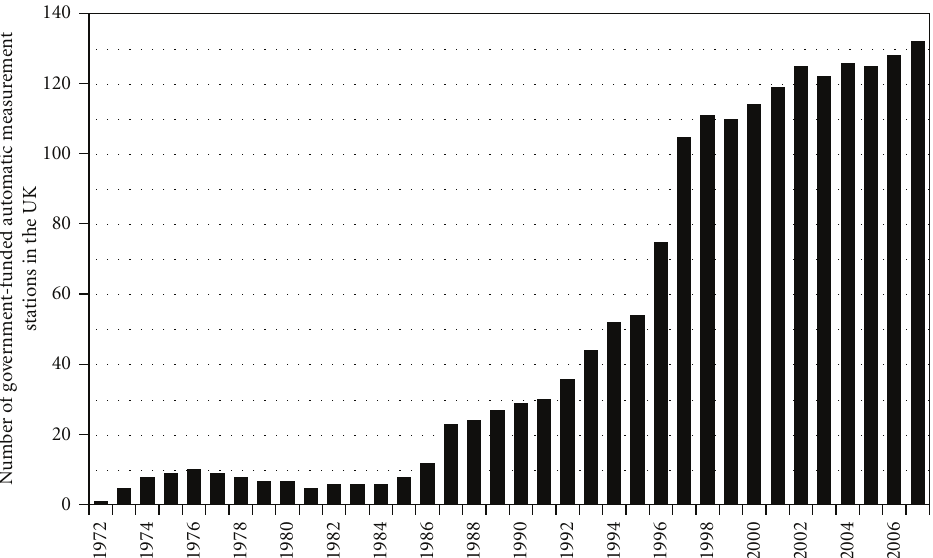
FIGURE 1: Evolution from 1972 to 2007 of the number of government-funded automatic measurement stations in the UK, reproduced from [3].